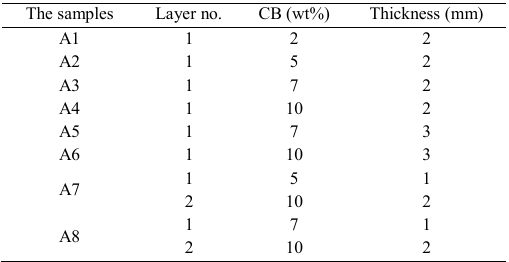
Table 1. The mix proportions and thicknesses of samples.